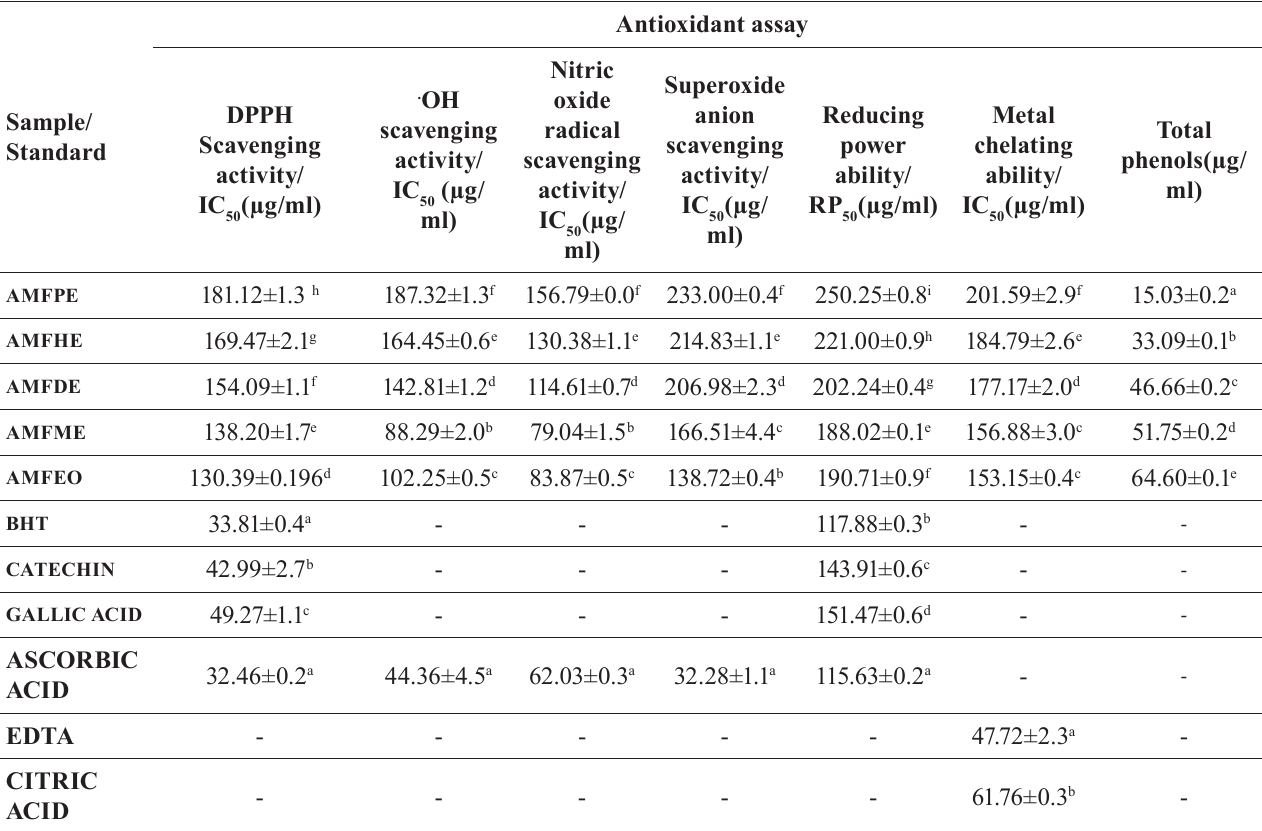
values for different extracts of A. malaccensis along with their total phenolic 50